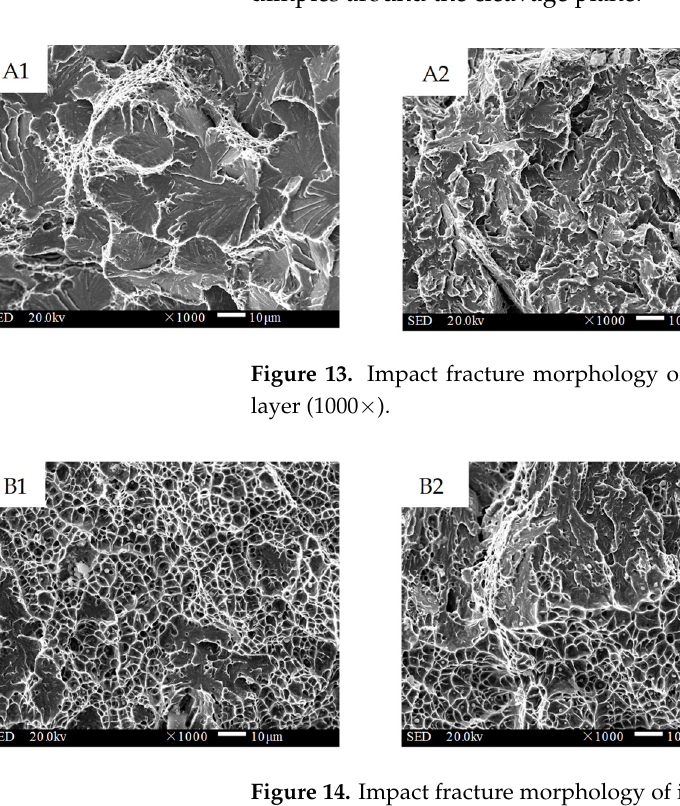
Figure 15. Impact fracture morphology of interface C between the intermediate and the strengthen- ing layer (1000×). 4. Production Application To evaluate the feasibility of manufacturing and the overall performance of the gra- dient layers of the die, a hot forging die for a vehicle control arm was remanufactured in a forging enterprise, as depicted in Figure 16. As seen in Figure 16a, the surface of the die exhibited numerous cracks and large deformations, and the edges of the cavity were se- verely abraded. This forging die had to be repaired to prolong its service life. Therefore, gradient wire arc additive remanufacturing was conducted for this hot forging die. First, the failure zone was removed (Figure 16b) using carbon arc gouging so that the designed remanufacturing zone could be obtained. Then, the remanufacturing zone of the hot forg- ing die was divided into three deposition layers (as illustrated in Figure 3). Subsequently, wire arc additive remanufacturing with multiple materials (transition, intermediate, and strengthening layers) was performed on the die cavity, as revealed in Figure 16c. Finally, post-machining and polishing were carried out to obtain the required die cavity, as dis- played in Figure 16d. In practical production applications, Figure 17a presented the failed hot forging die using gradient material remanufacturing after a period of service. The original single-material die had an average lifespan of 4000 pieces, while the die